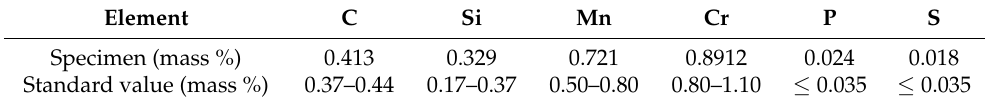
Table 2. The M60 high-strength bolt’s mechanical properties. Bolt